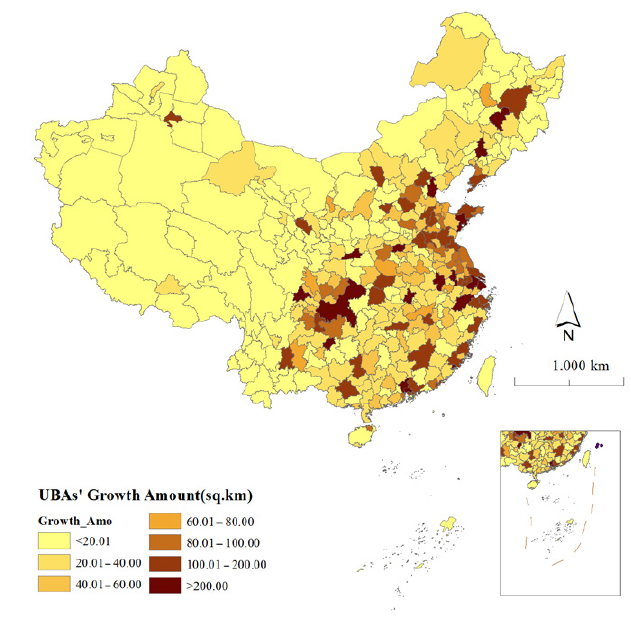
Figure 3. Expansion of urban built-up area of 289 cities